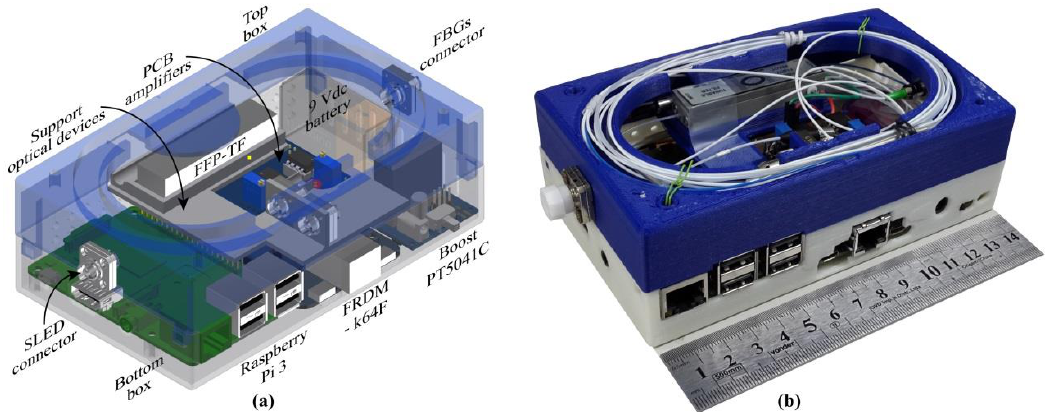
Figure 2. Representations of the portable interrogator: ( a ) 3D design and ( b ) picture of the portable interrogator.